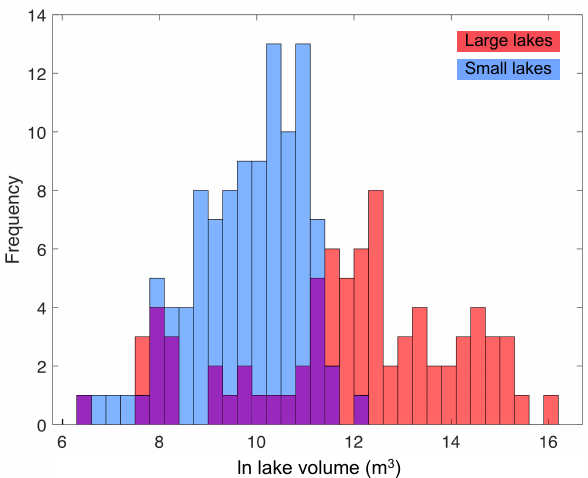
Figure 8. Dates of rapid drainage events for small (circles) and large (triangles) lakes in 2016. The panel coverage and background are the same as that shown in Fig. 1. The extreme colour bar values include those dates outside of the range shown (i.e. before 19 June and after 5 September).